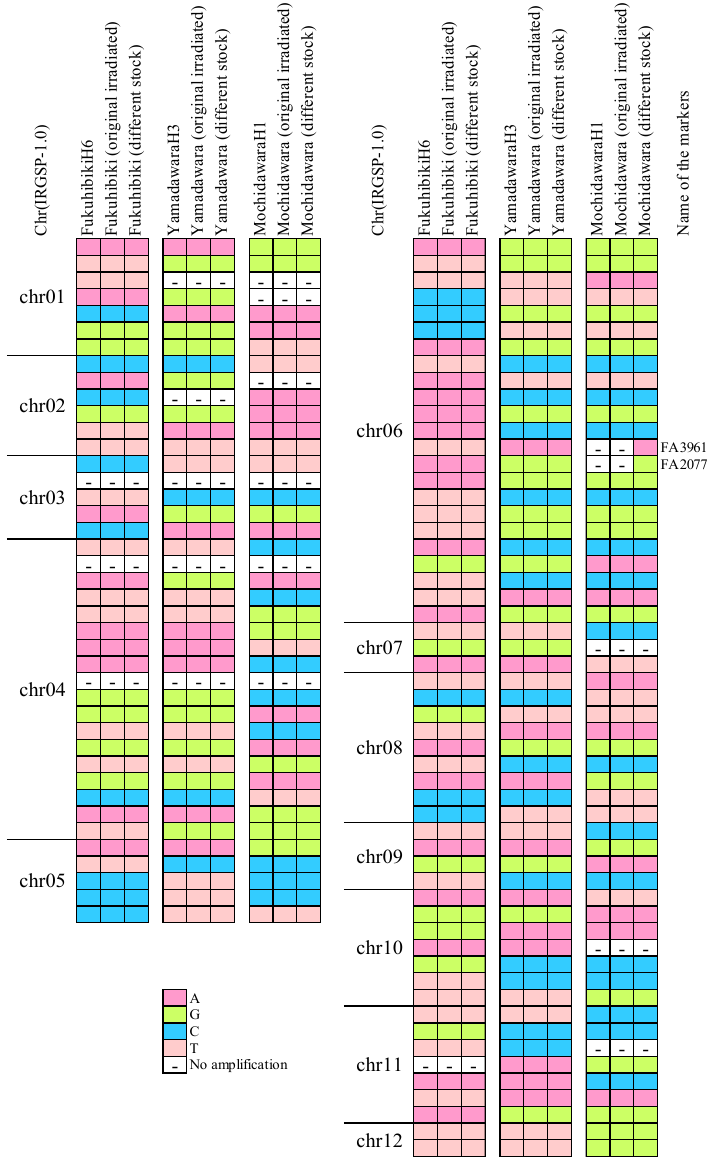
Figure 2. SNP genotyping of FukuhibikiH6, YamadawaraH3, and MochidawaraH1 by 96 SNP markers in 2017.